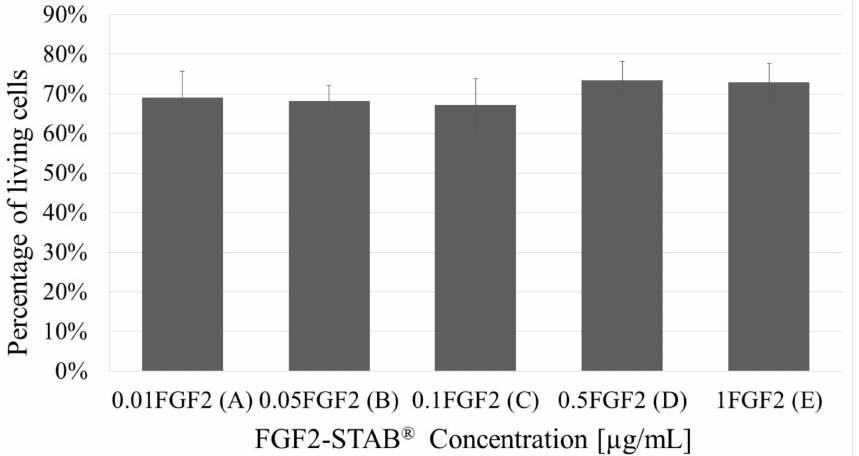
Figure 11. The live/dead assay in day 21 of samples with increasing FGF2-STAB ® concentration (0.01, 0.05, 0.1, 0.5 and 1 µ g/mL, for A – E , respectively). No statistical significance. The viability of cells after 3 weeks of incubation with Coll/Chit samples is about 70% in all measured concentrations of FGF2-STAB ® . The live (green) and dead (red) cells distribution within the samples in day 7 and 21 shows Figure 12. The deep projection from confocal microscope in 200 µ m depth shows overall cells distribution within the whole sample volume.